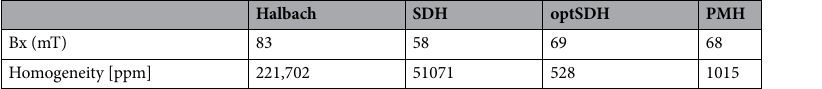
Table 1. Comparison of different rotation rules for a long ( L / R ≈ 9 ) length elliptical magnet ( ε = 0.5